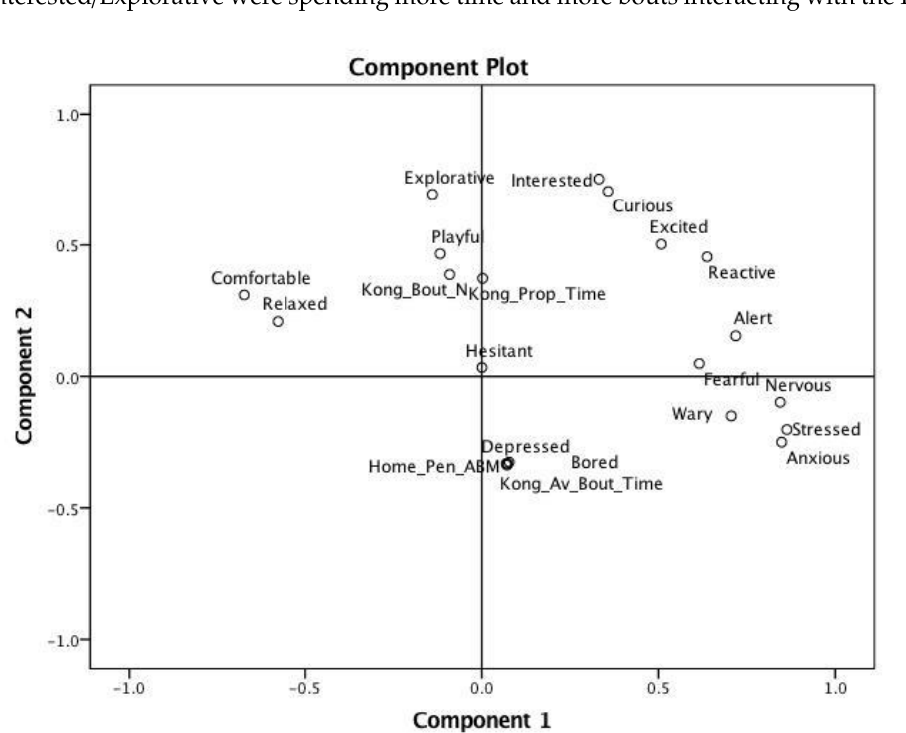
Figure 2. QBA scores overlaid with Kong TM test variables and home-pen awake but motionless ABM behaviour. The axis for Component 1 (25.3% of variance) reflects Stressed/Anxious to Comfortable/Relaxed, whilst the axis for Component 2 (15.5% of variance) reflects scores for Interested/Explorative to Bored/Depressed. When interpreting Figure 2 and Table S2, it is important to note that all QBA participants (n = 6) were blinded to the dogs’ prior ethogram home -pen and Kong TM test scores.